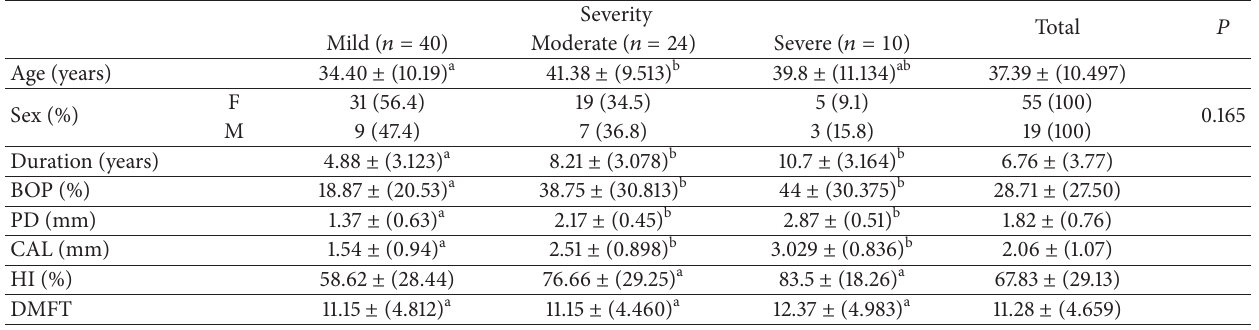
Table 1: Comparisons of demographic and periodontal characteristics between severity groups.